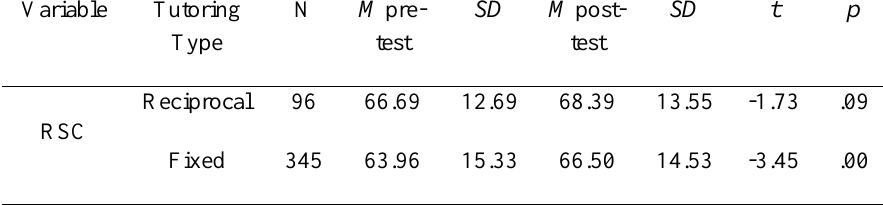
Reading Self-Concept (RSC) pre-test and post-test results in IG according to tutoring type (fixed/reciprocal) Variable